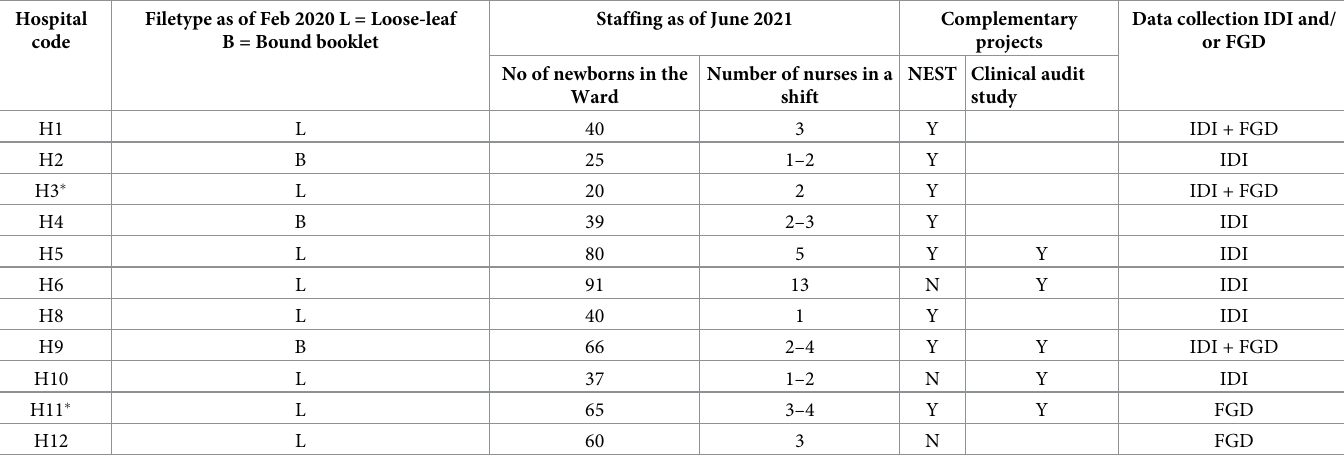
Table 2. Hospital